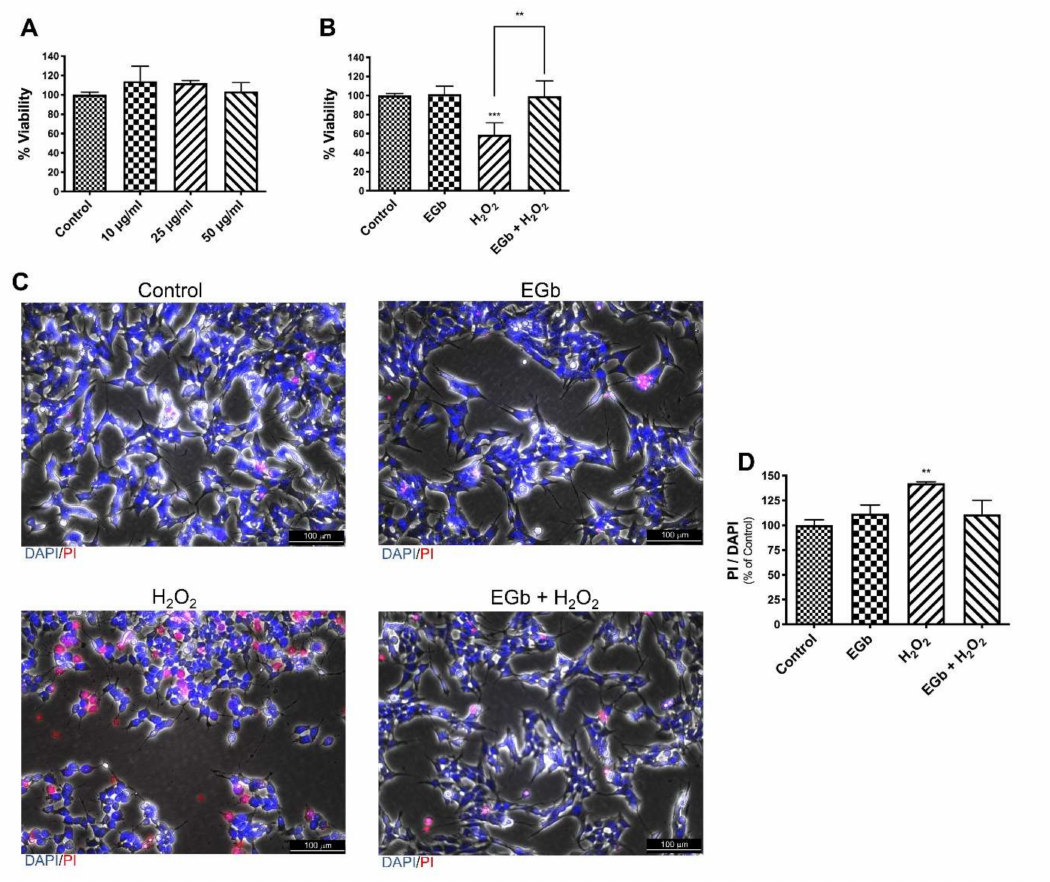
Figure 2. E ff ects of EGb on cell viability. Cell viability after treatments with di ff erent concentration of EGb ( A ). Cell viability after treatments with 25 mg / mL of EGb, 75 mM of H 2 O 2 or a combination of them ( B ). Cells treated with DMSO were used as control. Fluorescent microscopic image of DAPI / PI stained cells; DAPI: blue; PI: red ( C ). Histogram reports quantification of fluorescence of DAPI and PI ( D ). The bars represent ± the average ± SD of independent experiments ( n = 3). Statistically significant di ff erence compared to control cells: ** p ≤ 0.01, *** p ≤